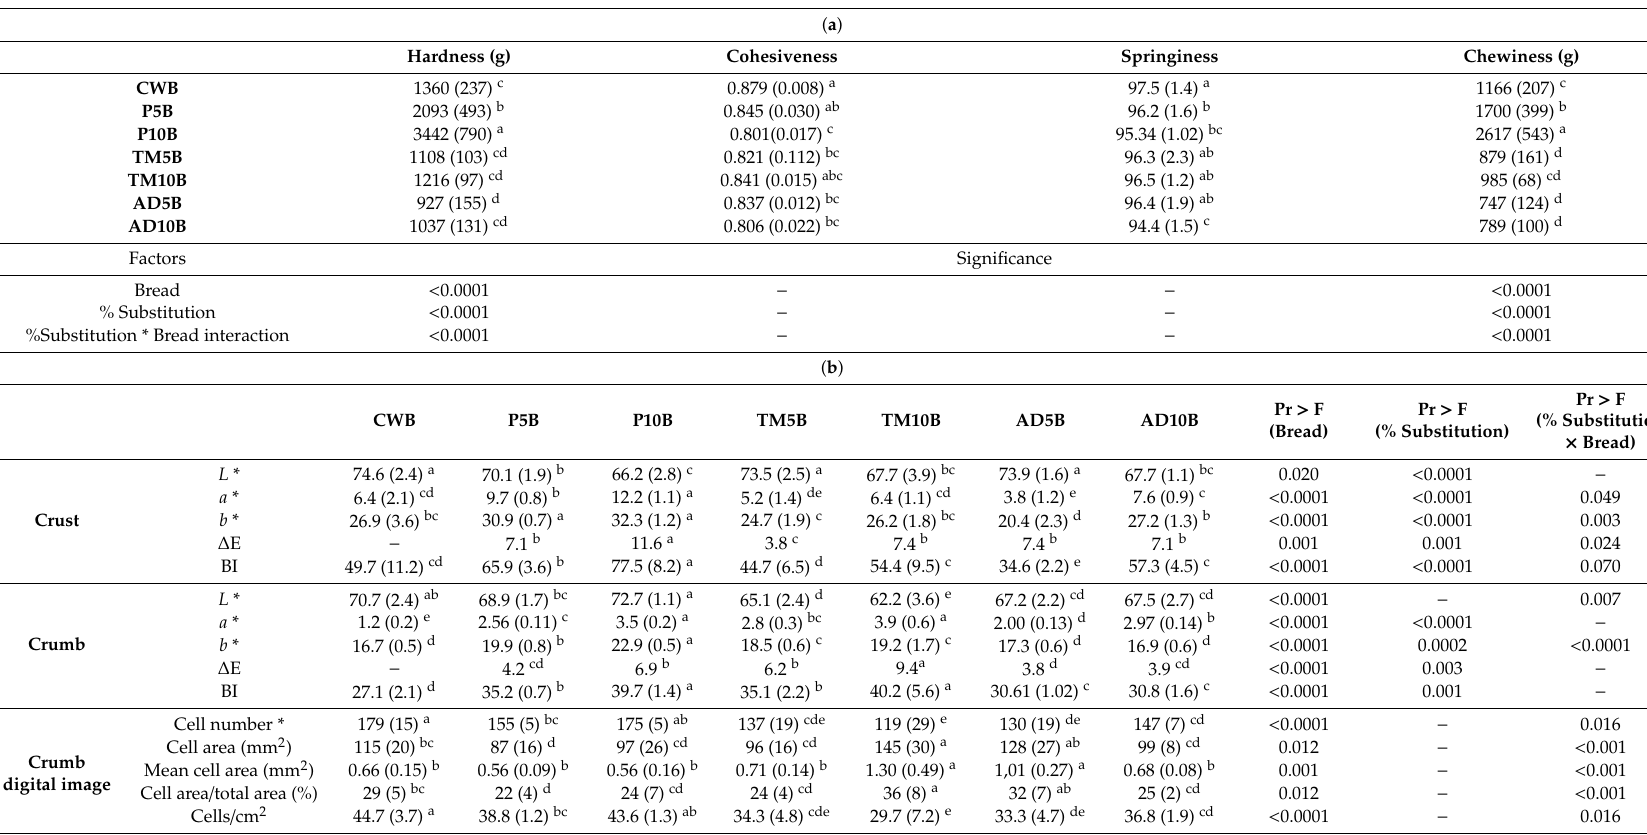
Table 3. ( a ) E ff ect of alternative protein addition on technological properties of bread: Crumb texture parameters. ( b ) E ff ect of alternative protein addition on technological properties of bread: colour and structural